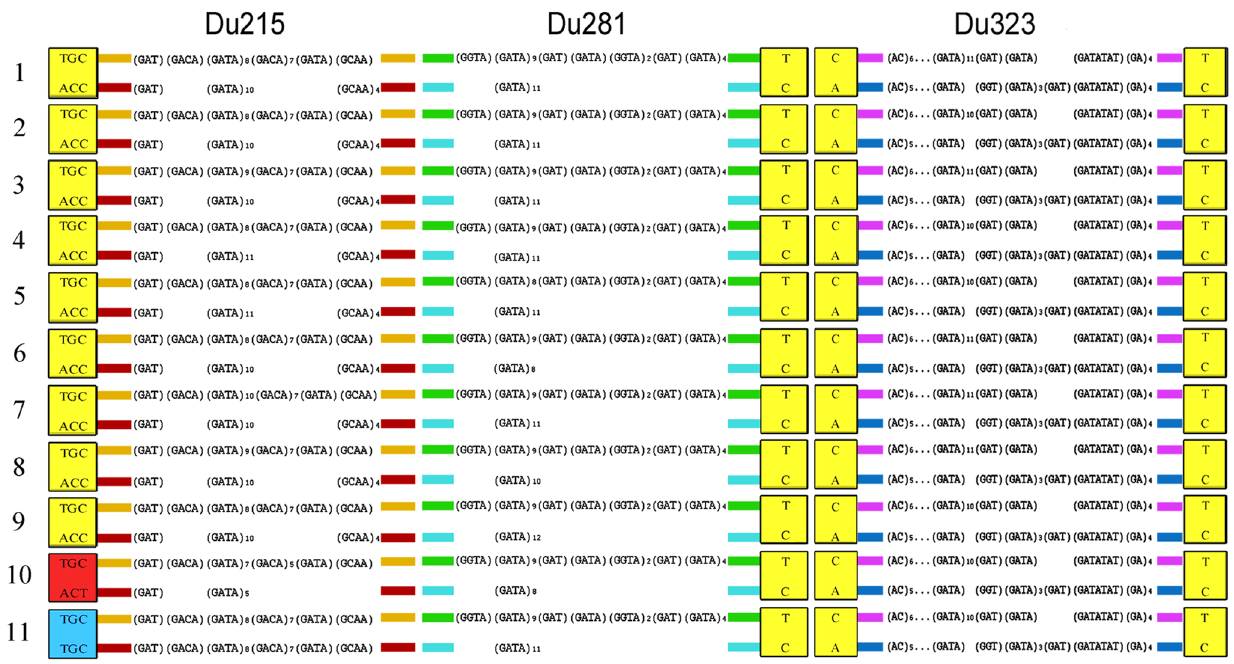
Figure 2. Schematic representation of 11 genotypes formed by allelic combinations of microsatellite loci Du215, Du281, and Du323 in 111 D.dahli individuals. Parental-specific SNV markers are shown in square. Variable microsatellite clusters are shown in each of two alleles.